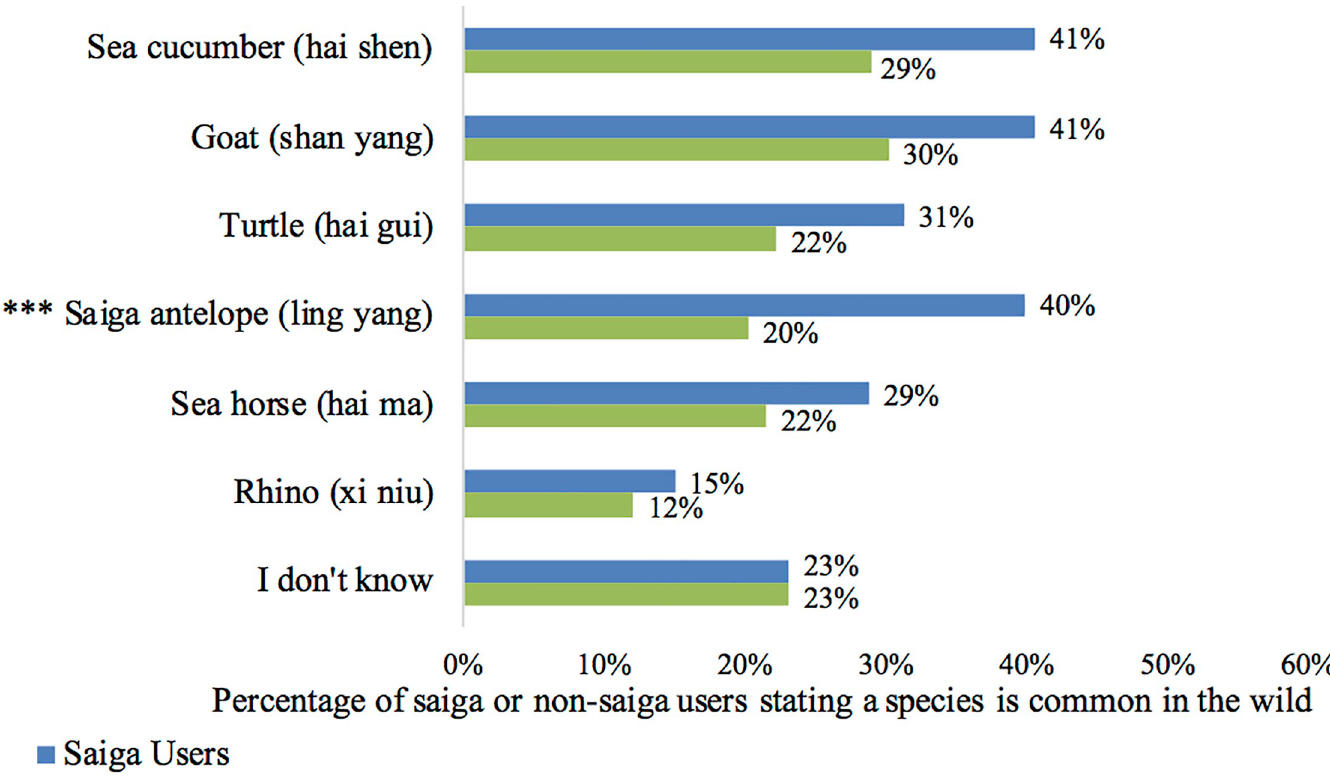
Fig 3. Perceived commonness of species in the wild. ��� indicates a statistically significant association between saiga users and perceiving that animal as common (p- value < 0.001, Pearson’s Chi-squared test). Percentages out of 438 participants for saiga users and 1,856 for non-users.